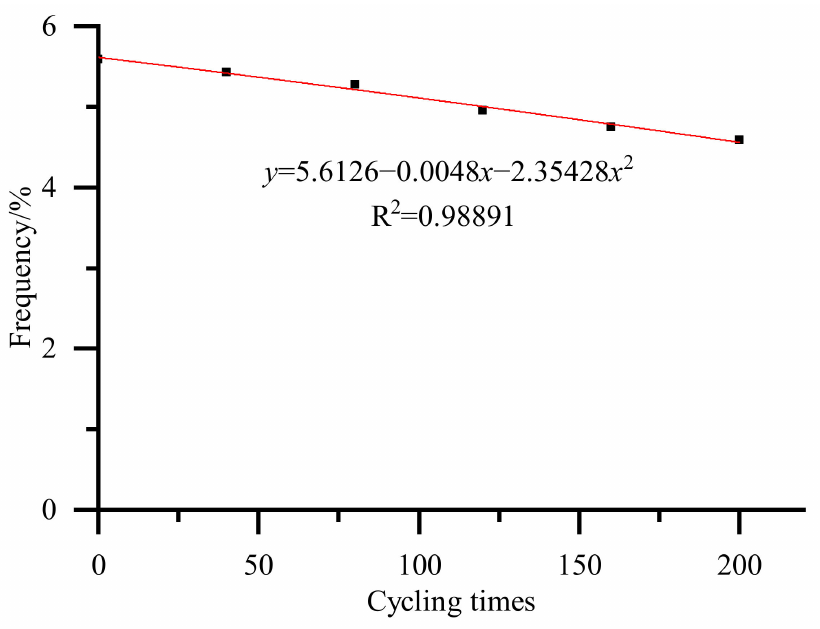
Figure 14. Critical differential pressure of gas production for different cycling times of gas injection and